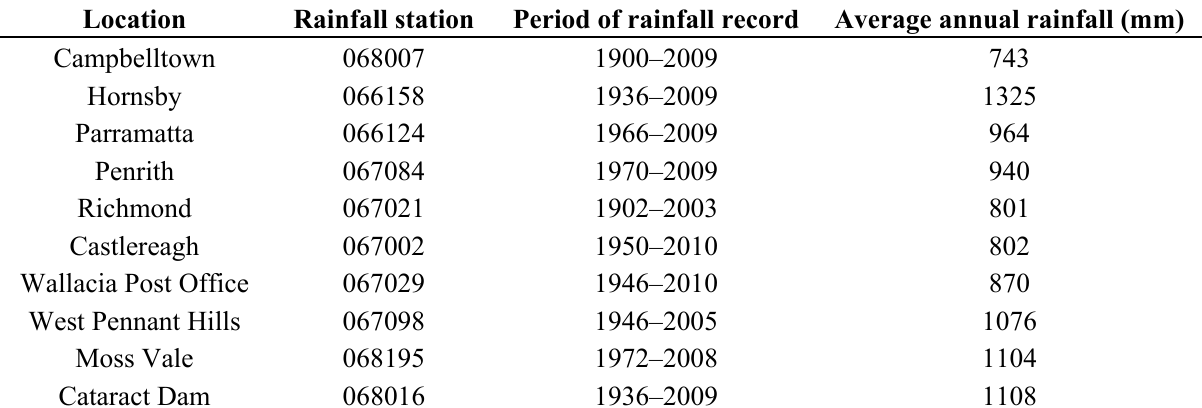
Table 1. Study locations and details of selected daily rainfall data.